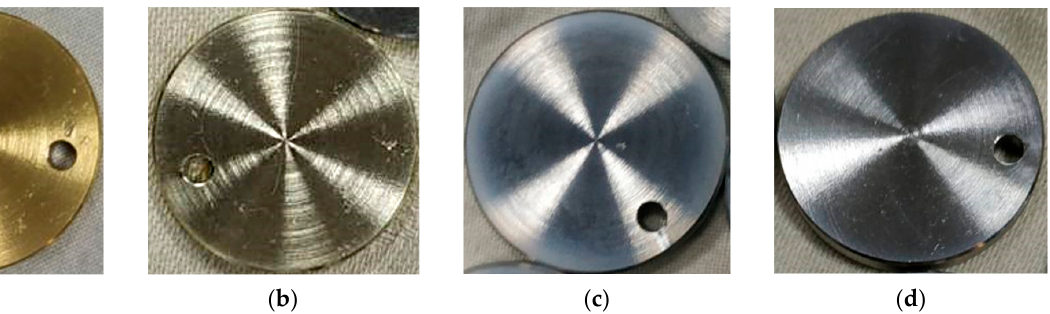
Figure 2. Optical microscopy images showing general view of the samples with the ( a ) Ti-TiN, ( b ) Zr-ZrN, ( c ) Cr-CrN, ( d ) Mo-MoN coatings under consideration.